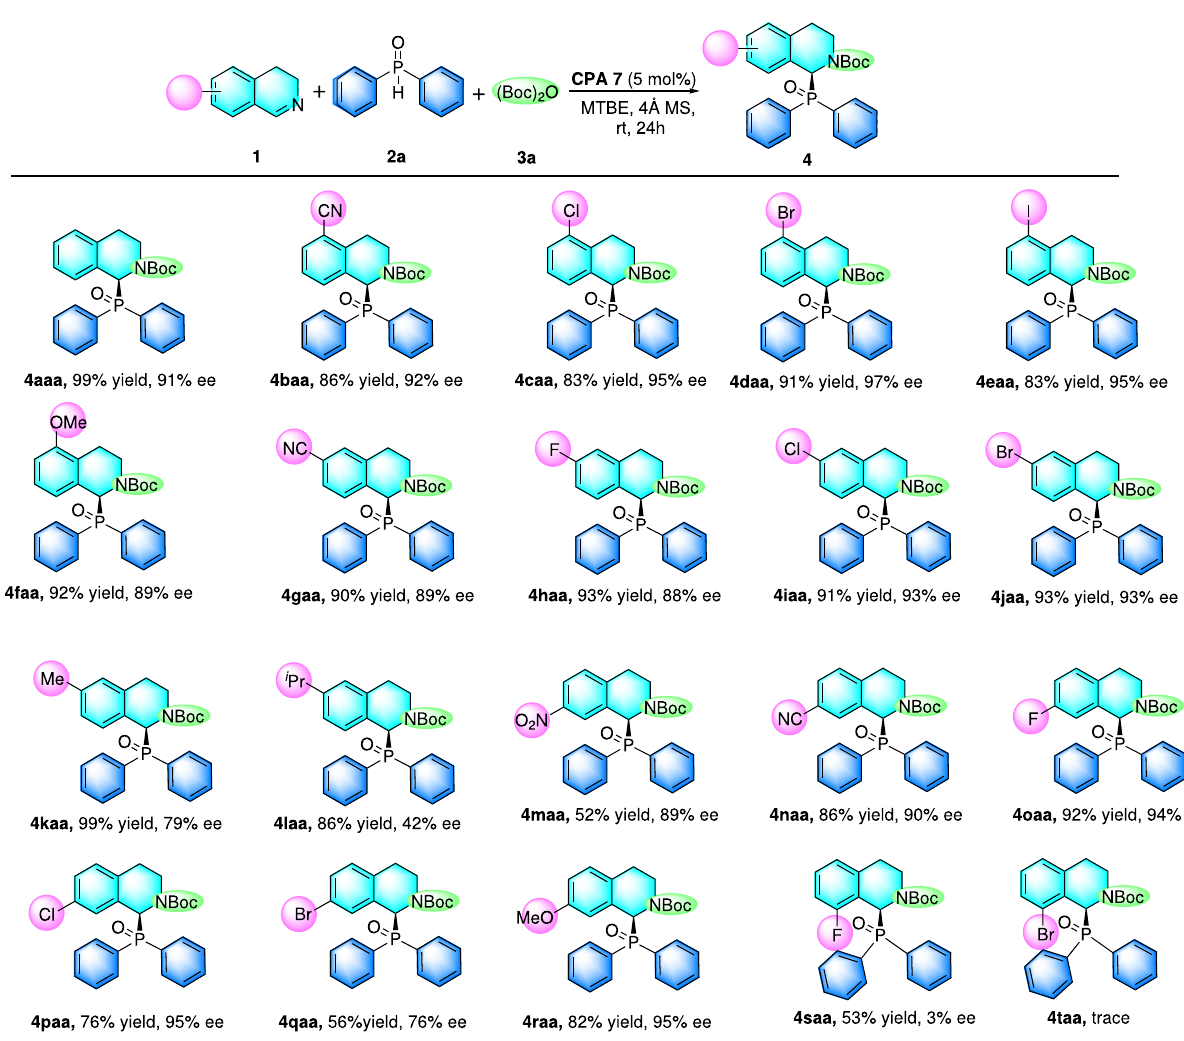
Fig. 2 Scope of 3,4-Dihydroisoquinolines. a Reaction conditions: 1 (0.2 mmol), Boc 2 O 3a (0.3 mmol) and CPA 7 (5 mol%) at 50 °C for 0.5 h. 4 Å MS (50 mg), MTBE (2 mL) and 2a (0.24 mmol) was added, and the mixture was stirred at room temperature for 24 h. Isolated yields were given here and ee value was determined by